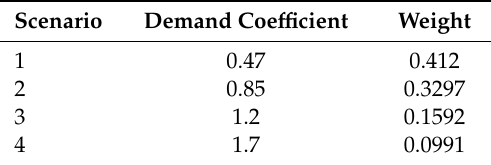
Table 3. Characteristics of the di ff erent scenarios, first case